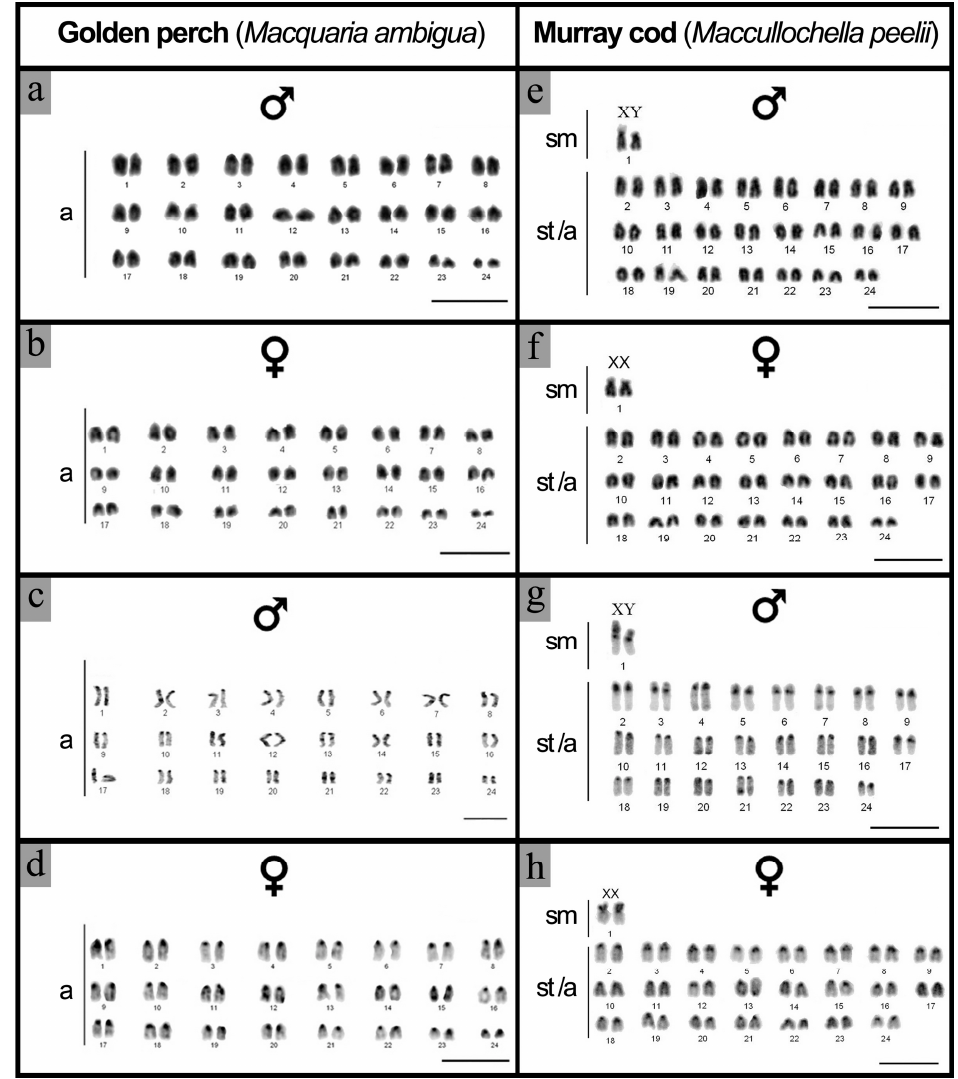
Figure 3. DAPI (4 ′ ,6-diamidino-2-phenylindole)-stained and C-banded metaphase karyotypes of golden perch and Murray cod; ( a ) golden perch male karyotype; ( b ) golden perch female karyotype; ( c ) C-banded karyotype of golden perch male; ( d ) C-banded karyotype of golden perch female; ( e ) Murray cod male karyotype; ( f ) Murray cod female karyotype; ( g ) C-banded karyotype of Murray cod male; ( h ) C-banded karyotype of Murray cod female. DAPI-stained metaphases were inverted. Scale bar 5 µm.